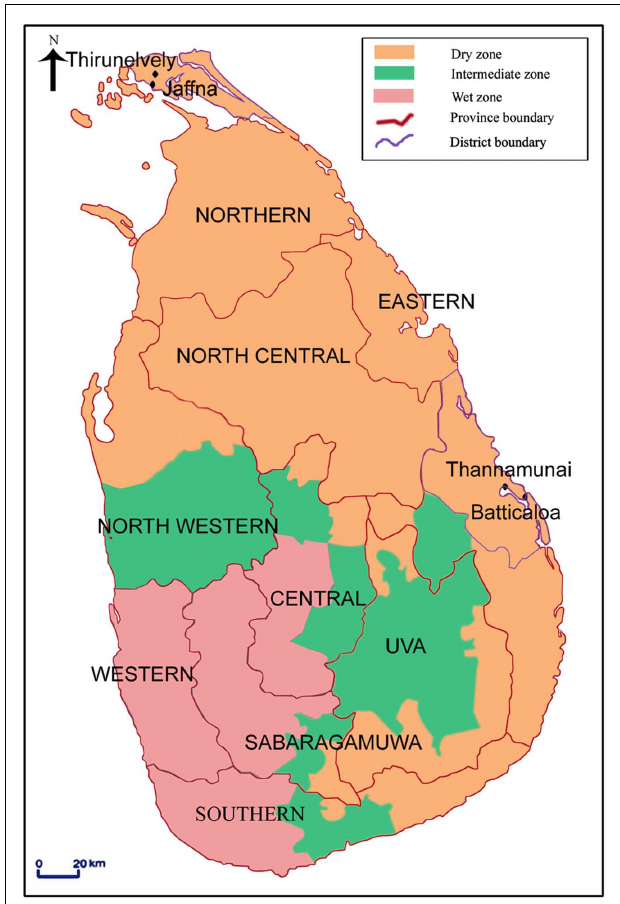
FIGURE 2 | Map of Sri Lanka showing the different provinces and the Aedes larvae collection sites in Jaffna and Batticaloa districts. Sri Lanka is an island in the Indian ocean with an area of 65525km 2 located between latitudes 5 (cid:48) 55 and 9 (cid:48) 50 North of the equatorThe central hills of the island divide the surrounding plains into two distinct rainfall zones: the wet and dry zones.The wet zone receives an annual rainfall exceeding 2500mm in two main rainy seasons: the North-East monsoon in October-December and the South-West monsoon in May-July. Inter-monsoonal rains also occur in the wet zone.The dry zone, with an annual rainfall below 2000mm, receives maximal rainfall during the North-East monsoon and little or no rain during the rest of the year. An intermediate zone, with mixed characteristics, lies between the dry and wet the intermediate zone.The beige, green, and pink shaded areas show the dry, intermediate, and wet rainfall zones respectively (reproduced with permission from Ramasamy et al., 2011).